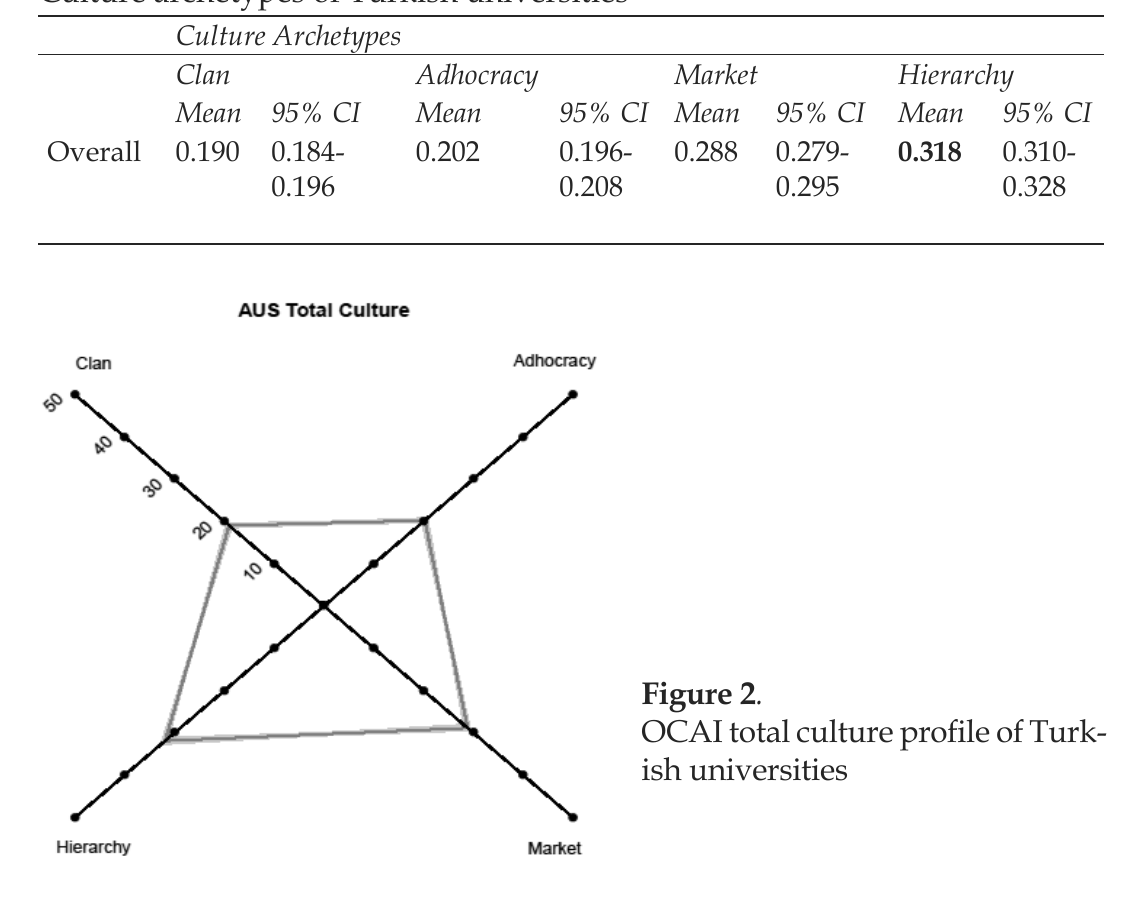
Culture archetypes of Turkish universities